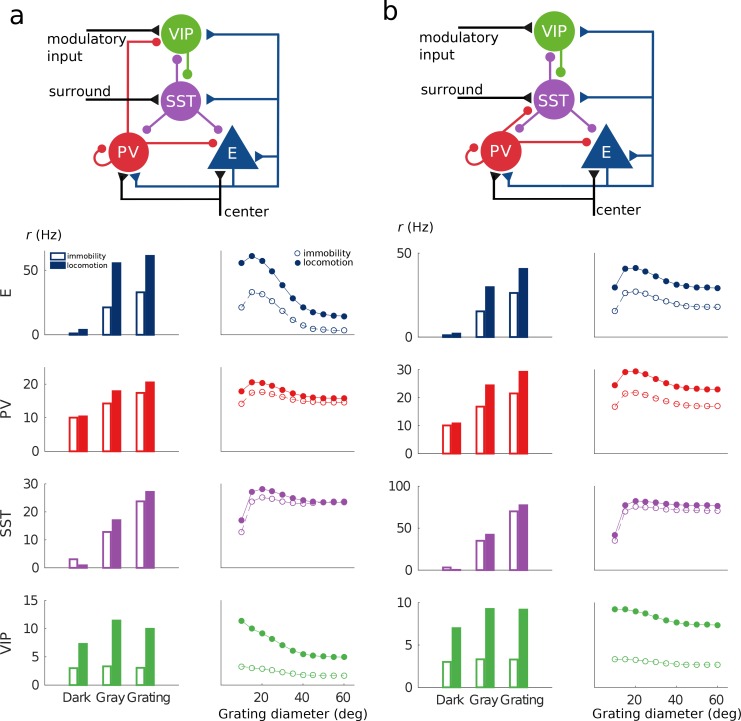
Alternative architectures.Two alternative microcircuits with visual input targeting E, SST and PV populations and PV to VIP (a) and PV to SST (b) connections exhibit the same qualitative behavior as the circuit in Figure 1 and Figure 4—figure supplement 1.